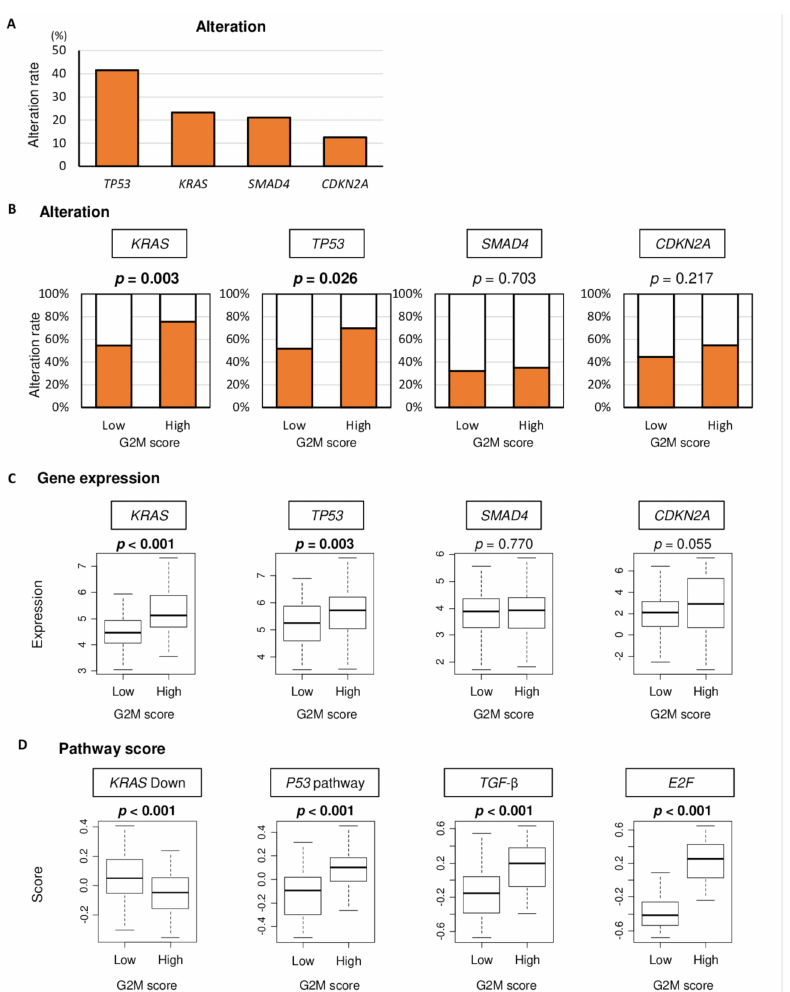
Figure 3. The association of G2M pathway score with alteration, expression, and signaling of KRAS, TP53, SMAD4, and CDKN2A genes in the TCGA cohort. ( A ) The percentage of patients with alteration of each gene in the TCGA pancreatic cancer cohort. ( B ) Percentage of patients with alteration of each genes in low or high G2M score groups. ( C ) Comparison of levels of KRAS, TP53, SMAD4, and CDKN2A gene expression by low and high G2M score groups. ( D ) Comparison of KRAS signaling up, P53 pathway, TGF - β signaling, and E2F target score by low and high G2M pathway score. High and low score groups were divided by the median value. Tukey-type boxplots show median and inter-quartile level values, and the ANOVA test is used to calculate p